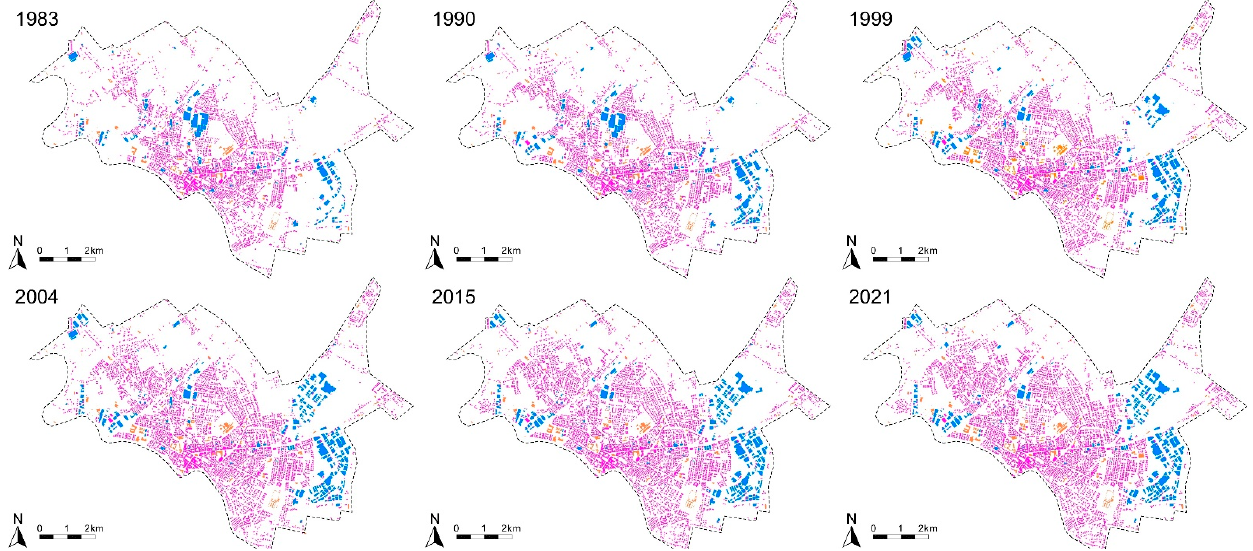
Figure 2. Maps of the building footprints in the study area in the last 40 years: residential buildings (pink), industrial and commercial buildings (blue), and other buildings (orange). Table 1 collects the value of absolute ( S ) and relative ( S REL ) footprint surface area,